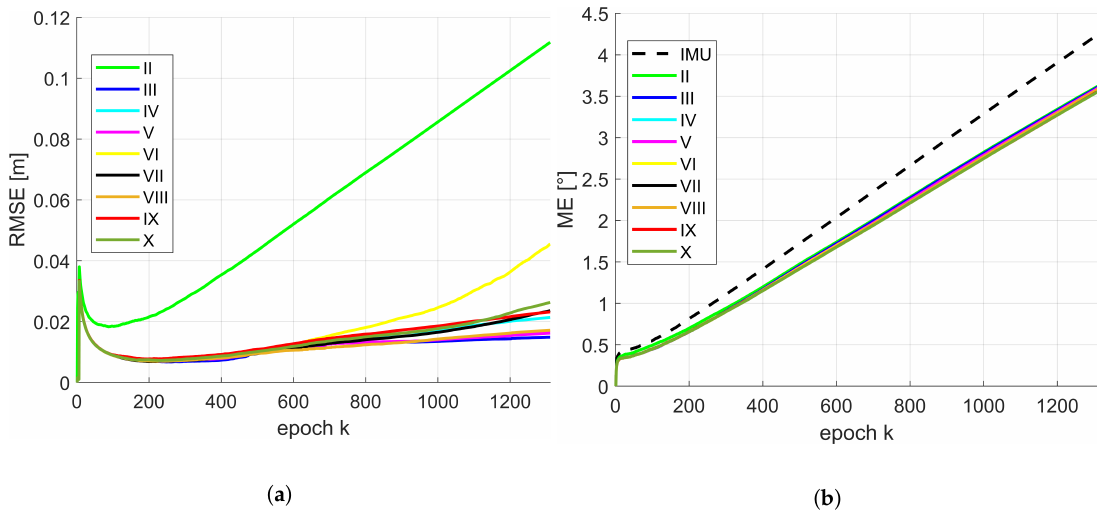
Figure 7. Moderate IMU: temporal progress of the median of the root mean square error (RMSE) for position ( a ) and mean error (ME) for orientation ( b ) by means of 500 replications for respective combinations of the state constraints applied. The Roman numerals refer to respective state constraints applied regarding Table